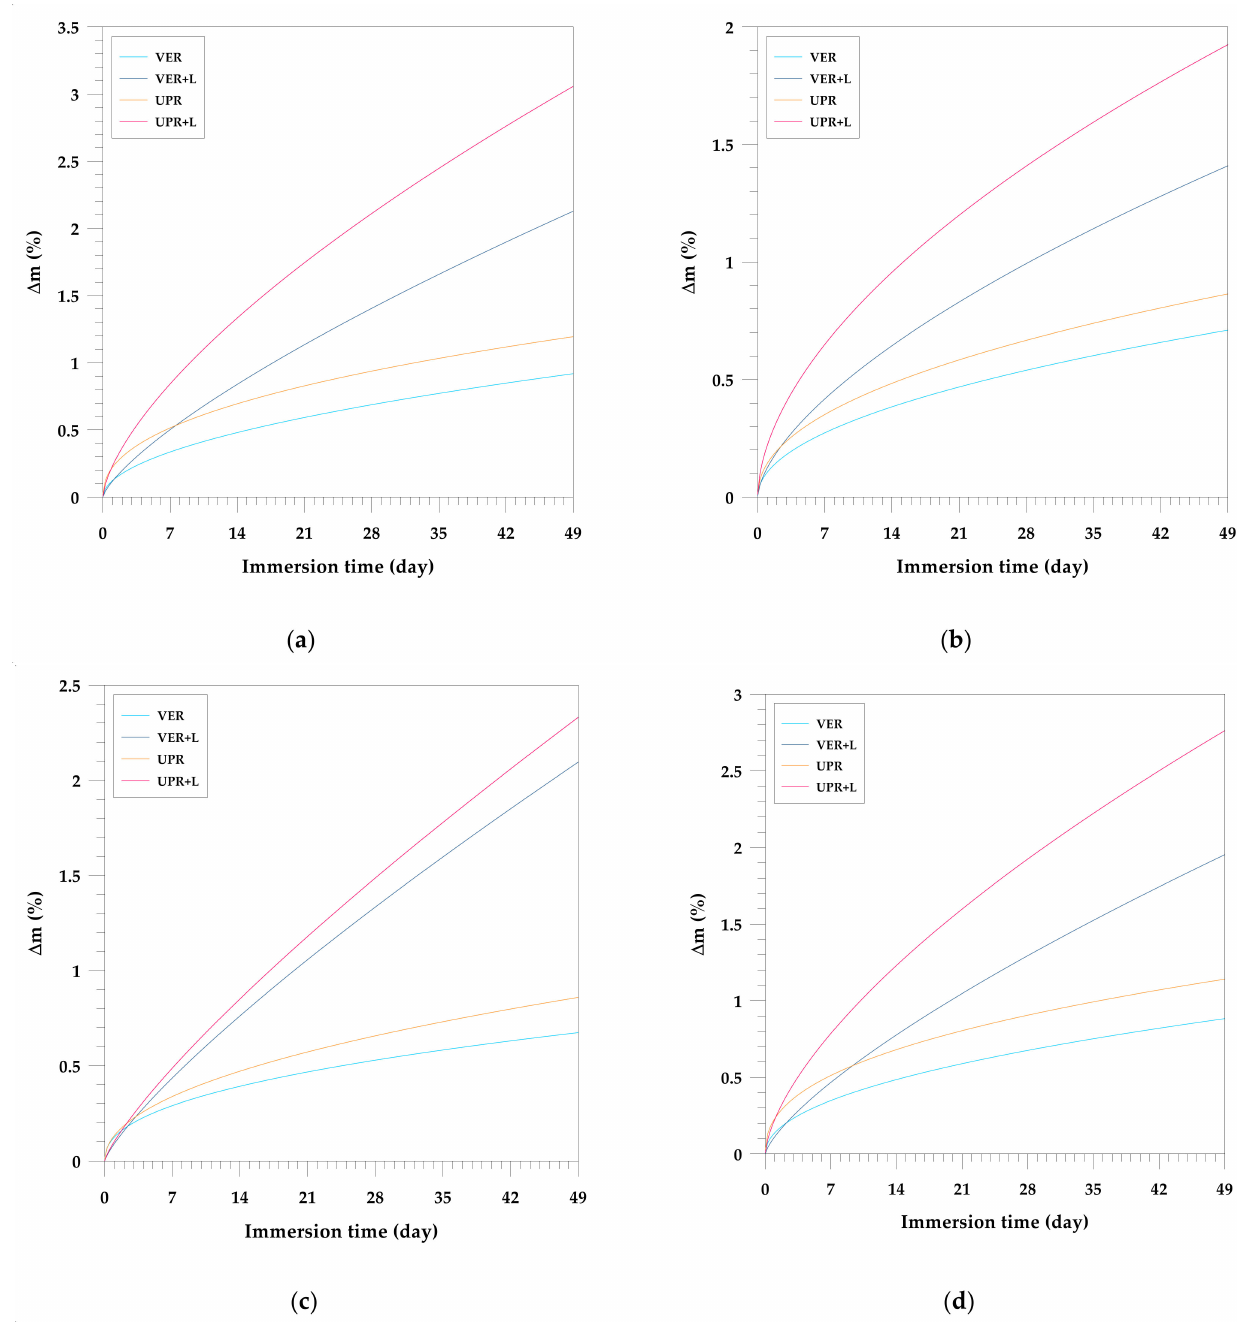
Figure 6. Effect of the chemical resistance of the UPR and VER composites with kraft lignin during immersion test in: ( a ) distilled water; ( b ) 10% HCl, ( c ) 1% NaOH, ( d ) 2% Na 2 CO 3